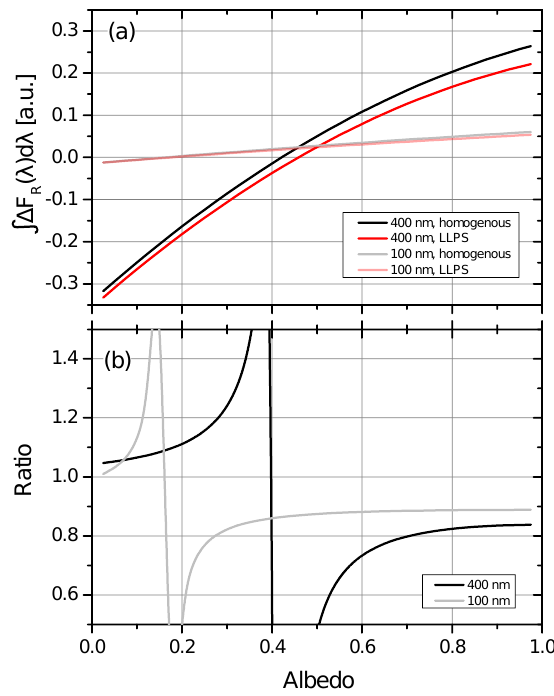
Figure 13. (a) Direct radiative forcing integrated over the visible solar spectrum for particles with OIR 1 : 4, AAE = 6 and k = 0 . 168 at 355nm. Results for two diameters are shown. (b) Ratio of forcing for LLPS morphology to homogeneous morphology; see Eq. (3) for the data of (a)